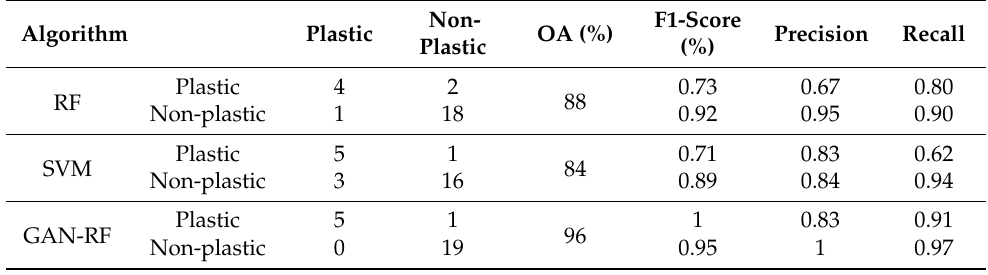
Table 3. Performance/confusion matrix based on the validation set data using RF and SVM